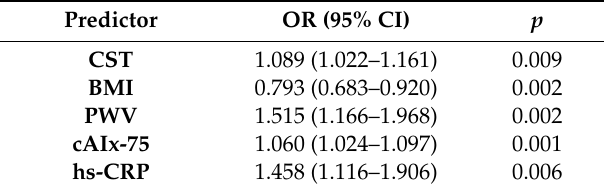
Table 7. Binomial logistic regression for the prediction of IBD